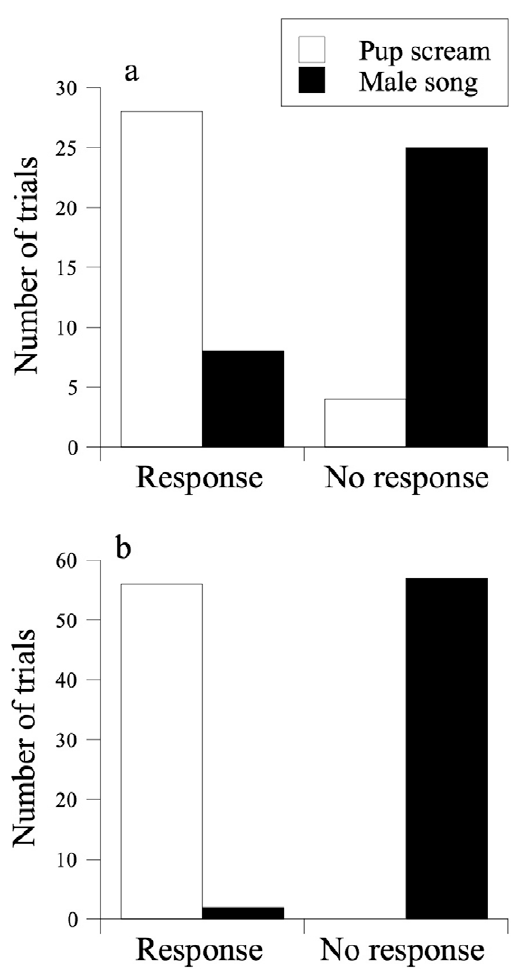
Figure 3. Playback experiments results. (a) The number of times males responded to playbacks of pup screams or foreign males’ songs by singing. White bars denote pup screams; black bars denote male songs. The response to pup scream was significantly stronger (Fisher’s exact test, P , 0.0001). (b) The number of times females responded to playbacks of pup screams or foreign males’ songs by looking in the direction of the speaker. White bars denote pup screams; black bars denote male songs. The response to pup scream was significantly stronger (Fisher’s exact test, P , 0.0001).